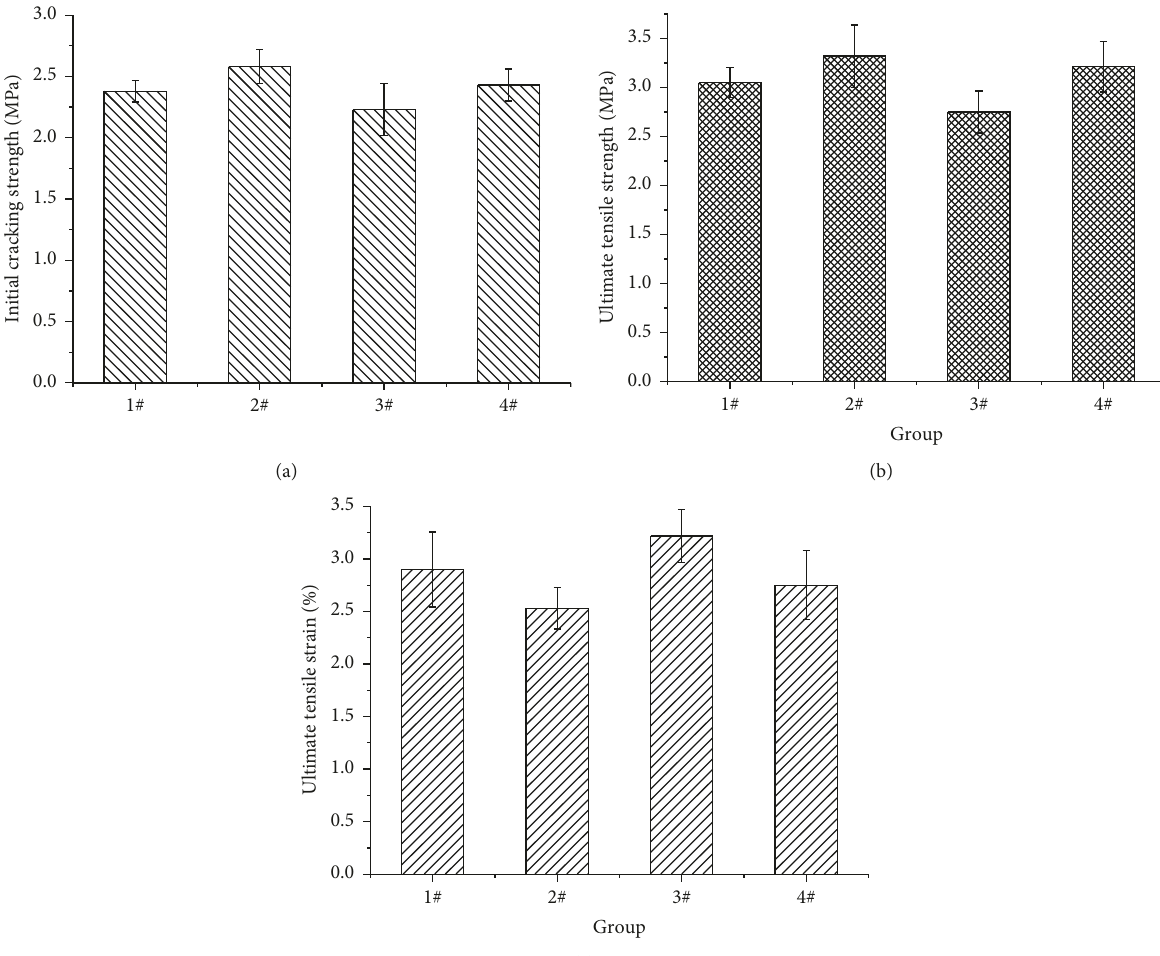
Figure 6: Results of uniaxial tensile test: (a) initial cracking strength; (b) ultimate tensile strength; (c) ultimate tensile strain.